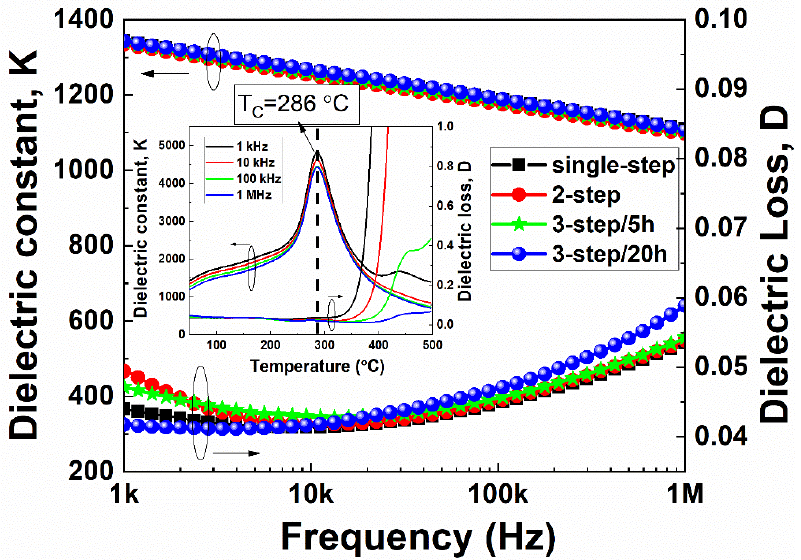
Figure 3. Variation of dielectric constant and dielectric loss with frequency at room temperature for 0.92KNLN-0.08BZ ceramics sintered under different conditions; the inset shows the temperature- dependent dielectric properties of the ceramic prepared using the 3-step/20 h method.